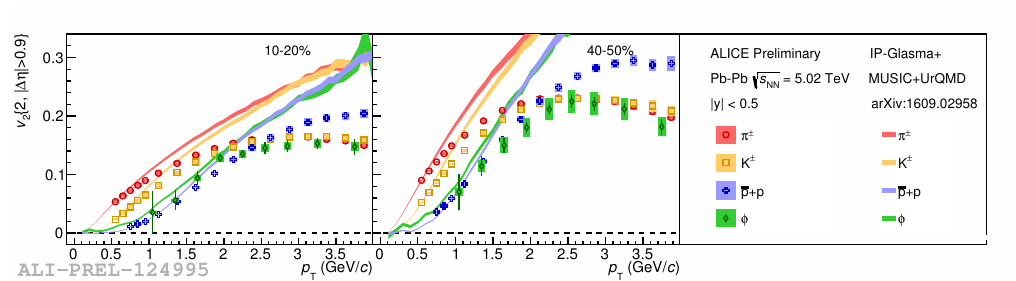
Figure 2. Flow coe ffi cient v 2 of π ± , K ± , p(p) and the φ -meson for 10-20% (left) and 40-50% (right) collision centrality compared to predictions from relativistic hydrodynamic calculations [9]. Statistical uncertainties are shown as bars and systematic uncertainties as boxes.